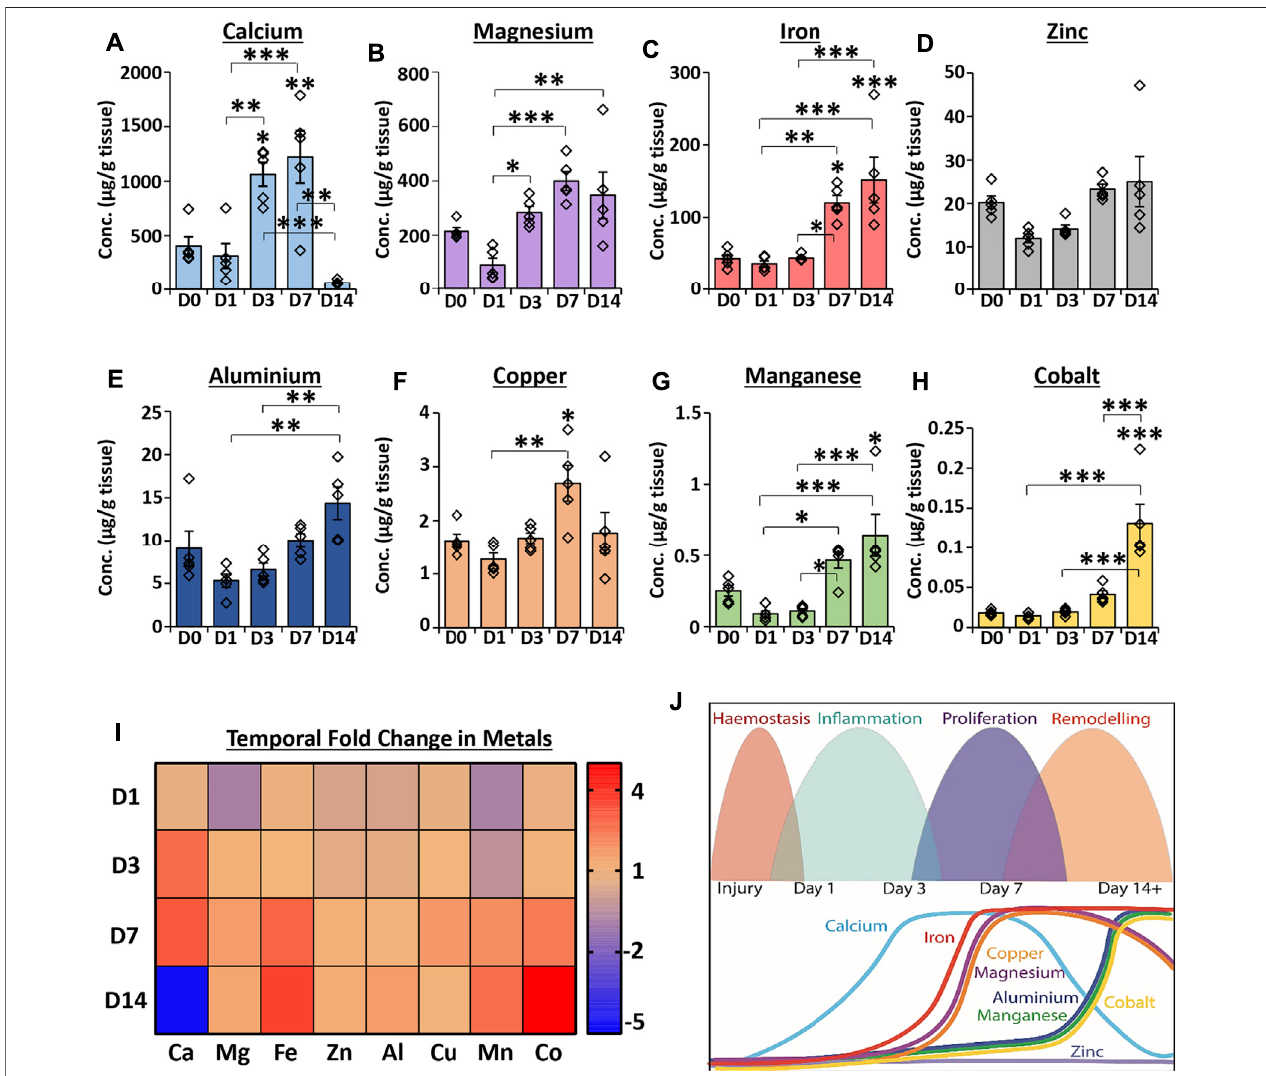
FIGURE 1 | Temporal pro fi ling reveals global changes in the metallome throughout normal wound repair. ICP-MS was used to measure metal abundance in skin andacutehealingwounds.Absoluteabundanceofindividualmetalsintissue (A – H) .Heatmaprelativetonormalskin(D0)wherethesaturatedredvalueis7 (I) .D1 (cid:2) day 1post-wounding.Schematicshowingtemporalmetalchangesalongsidethemainwoundhealingphases (J) .Mean ± SEM. n (cid:2) 5micepergroup.One-wayANOVAwith Tukey ’ s post-hoc analyses were performed. * (cid:2) p < 0.05, ** (cid:2) p < 0.01 and *** (cid:2) p < 0.001. Asterisk alone versus D0.